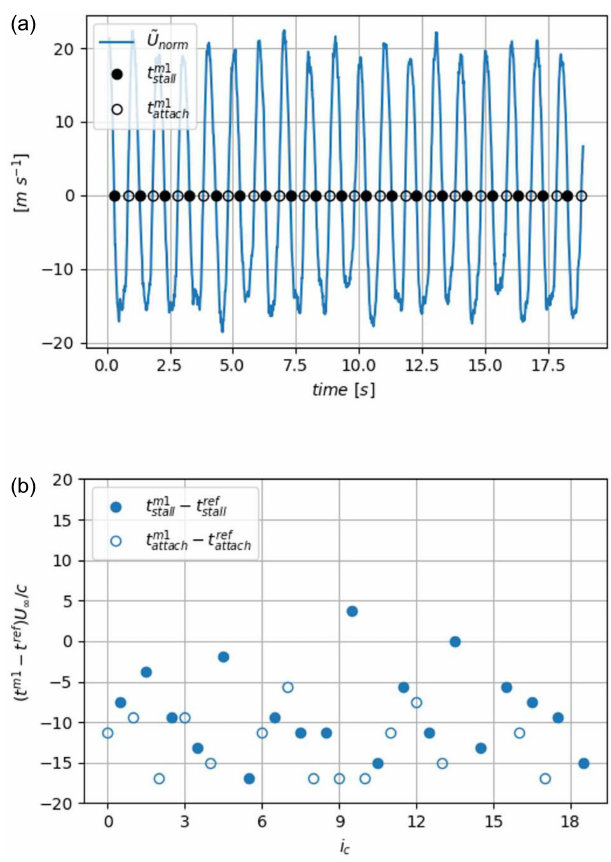
Figure 16. Results from the zero-crossing method applied to the (cid:101) U norm ( t ) (variations in U norm ( t )): (a) instantaneous signals with de- tected instants; (b) normalized delay of the stall and reattachment detected